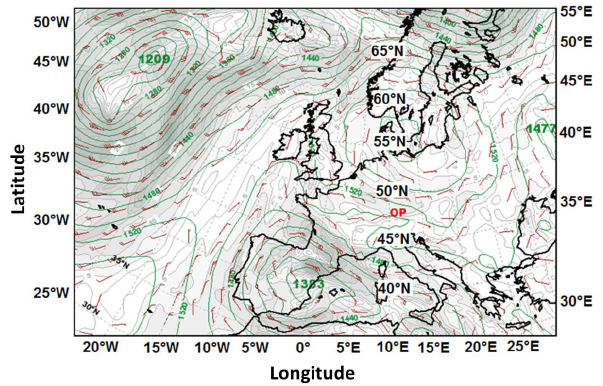
Fig. 1. Geopotential and wind field at 850hPa on 10 May 2008. OP marks the airport of Oberpfaffenhofen.